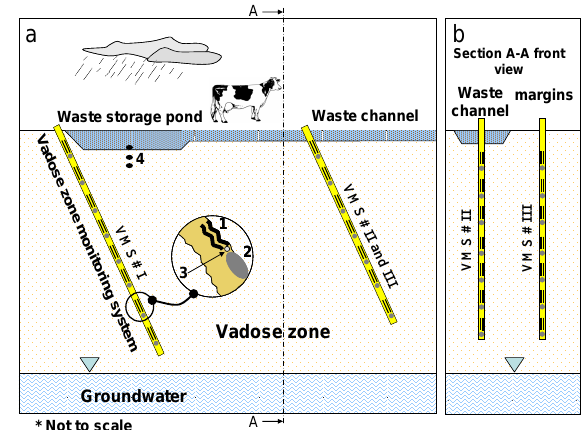
Fig. 2 . Desiccation cracks at the study site 822 Fig. 2. Desiccation cracks at the study site. samples from the waste sources (pond and channel) and from the vadose zone were collected every 6 to 12 weeks. Water